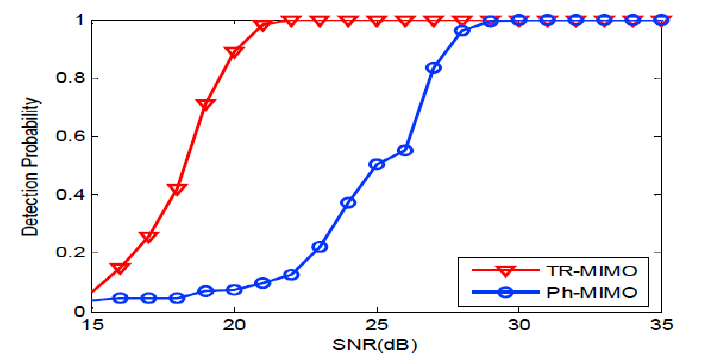
Figure 5. The probability of detection curves as functions of SNR for two sonar systems with LFM